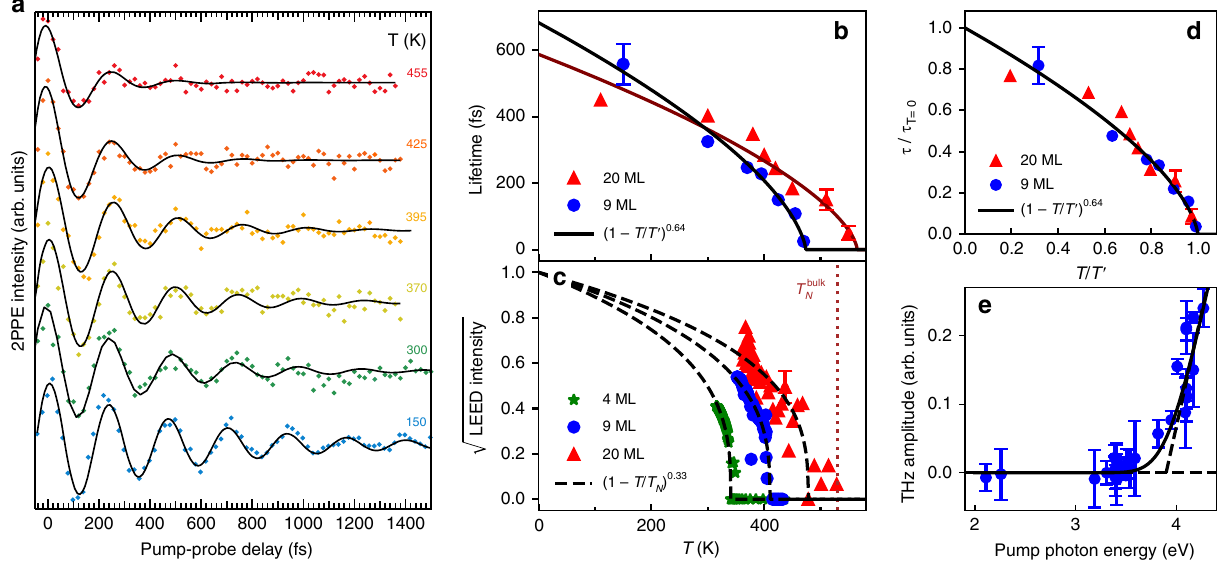
Fig. 3 Oscillatory contribution of the NiO(001) 2PPE signal for the in-gap state. a Time-dependent 2PPE signal of a 9 ML NiO(001) thin fi lm for temperatures between 150 and 455 K (1.2 eV intermediate state energy, h ν pump = 4.2 eV with 20 μ J/cm 2 and h ν probe = 3.4 eV with 200 μ J/cm 2 , slowly decaying background subtracted). The black solid lines describe exponentially damped harmonic oscillations. b Oscillation lifetime τ extracted from the time-dependent 2PPE signal for NiO(001) thin fi lms of 9 and 20 ML. The solid line indicates the critical behavior with a critical exponent ν = 0.64, as determined by neutron scattering 21 . c Antiferromagnetic scattering amplitude as extracted from the (2 × 1) magnetic superstructure spots in LEED as a function of temperature. Dashed lines indicate the extrapolation to T N with a critical exponent β = 0.33 as found in ref. 21 . d Relative oscillation lifetimes for 9 and 20 ML on a common reduced temperature scale. e Pump-photon energy dependence of the oscillation amplitude at t = 0 extracted from the time- dependent 2PPE signal for the NiO(001) thin fi lm of 9 ML at 300